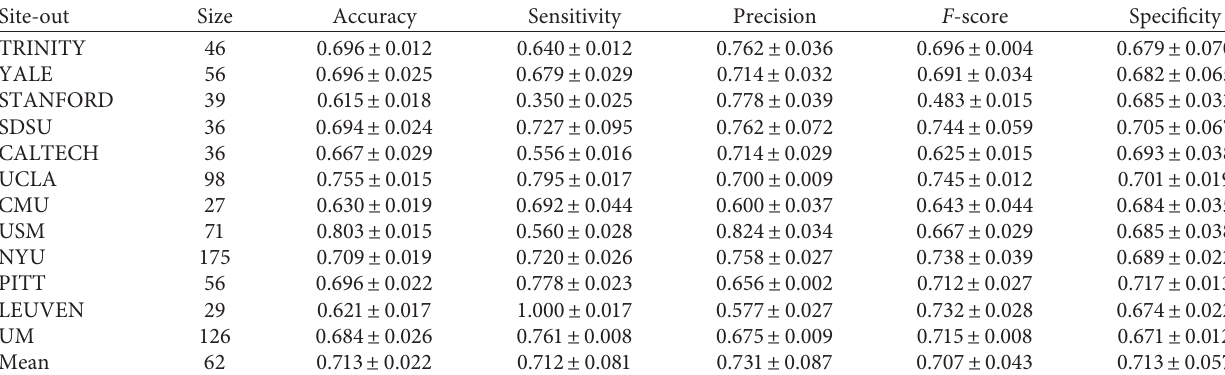
All data are mean and standard deviation.